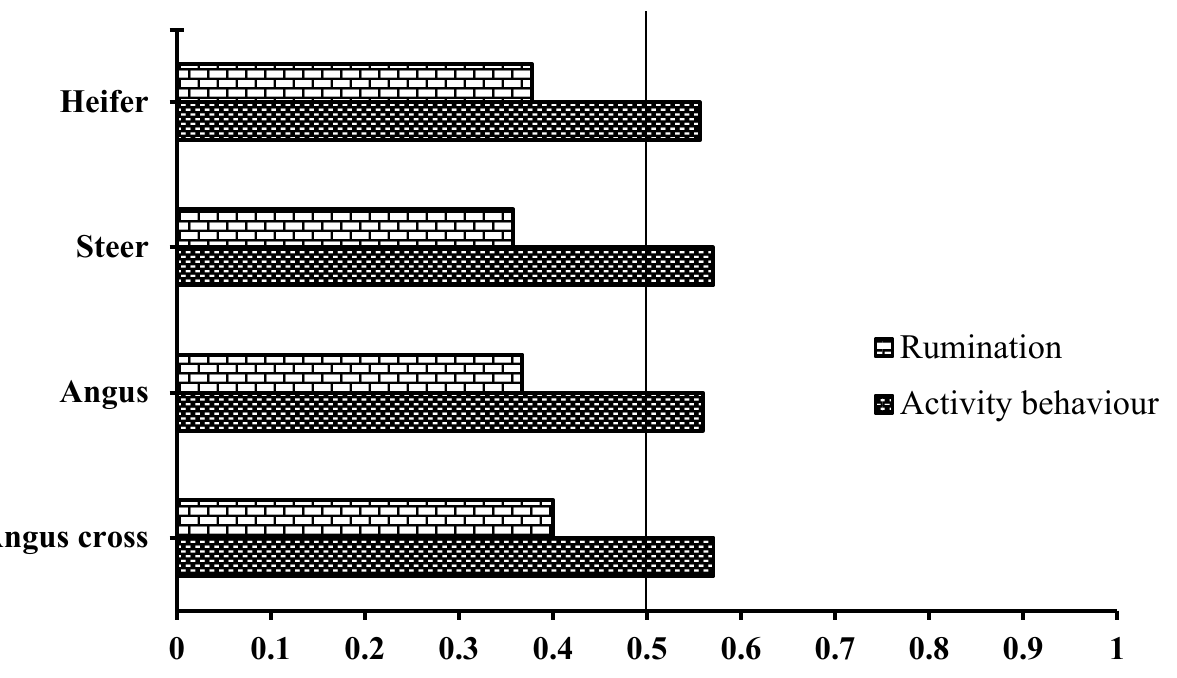
Figure 5. Diurnality index for rumination and activity behavior in the heifer, steer, Angus, and Angus- cross. The vertical line indicates the theoretical separation between nocturnal and diurnal activity (i.e., equal amounts of activity during the photophase and the scotophase of the light/dark cycle).